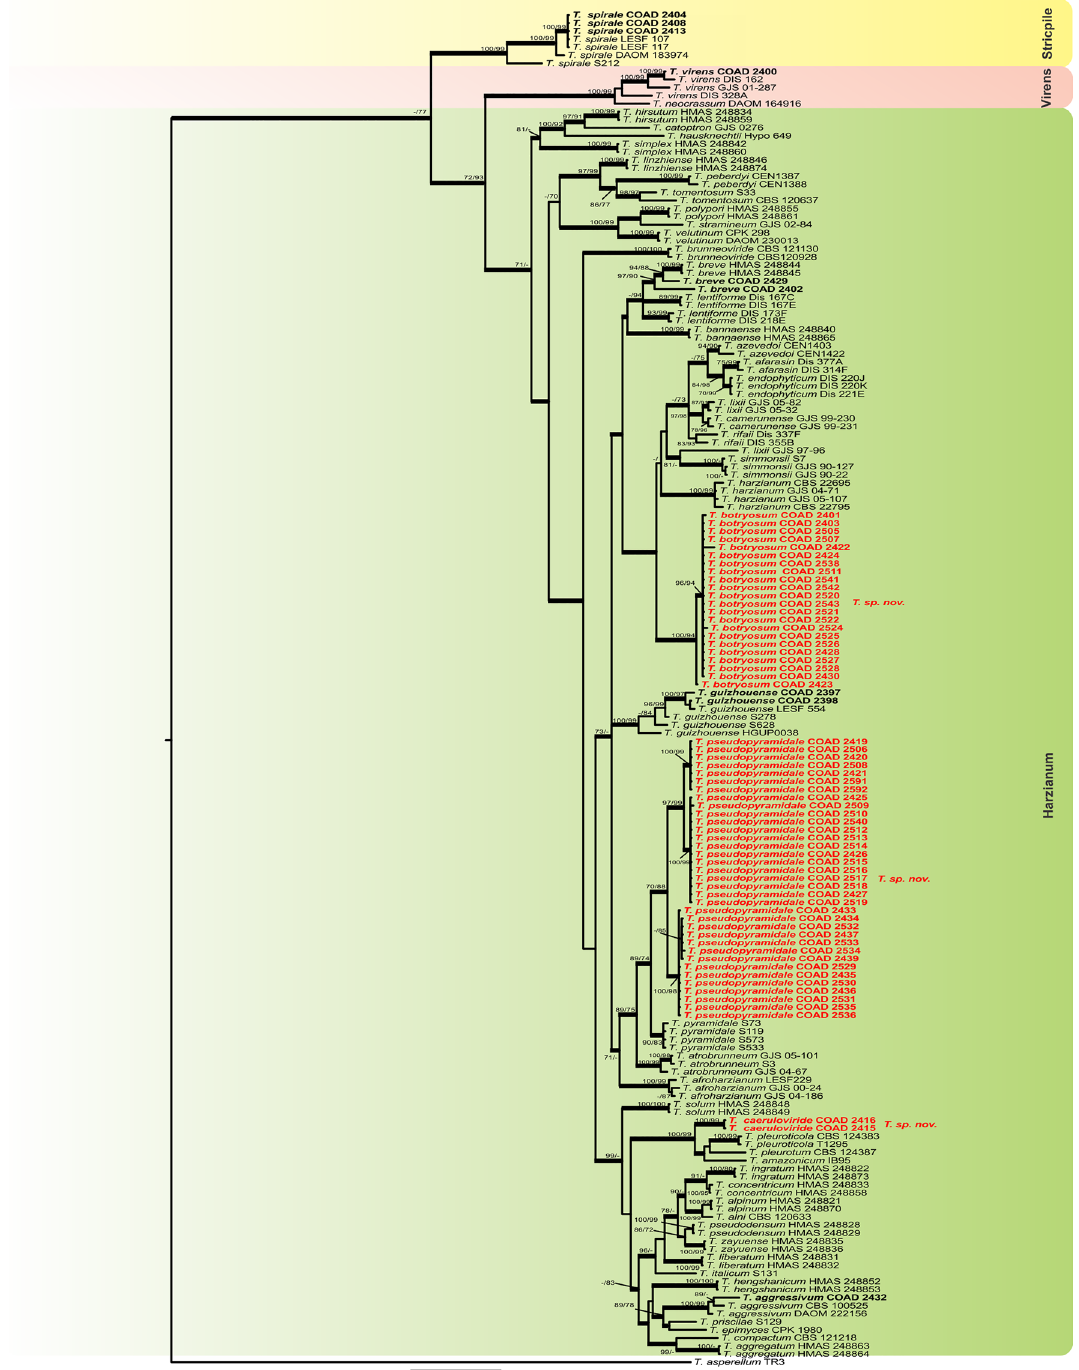
Figure 1. Bayesian phylogenetic tree of clades Harzianum , Strictipile and Virens . The tree was based on a concatenated tef1 and rpb2 sequence dataset. Bootstrap values (≥ 70%) of the ML and MP analyses, as well as posterior probability scores (≥ 0.9) from a Bayesian analysis of the same dataset, are indicated at well supported nodes together with thickened branches. The isolates belonging to known species, obtained in this study, are in bold. Isolates of new species, described in this study, are in bold red. The tree was rooted with Trichoderma asperellum (TR3). The phylogenetic tree was edited using Inkscape 1.0 (https ://inksc